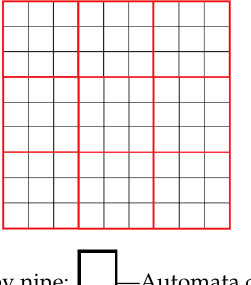
Figure 2. Field cells grouped by nine: —Automata cells; —Nine cells group.